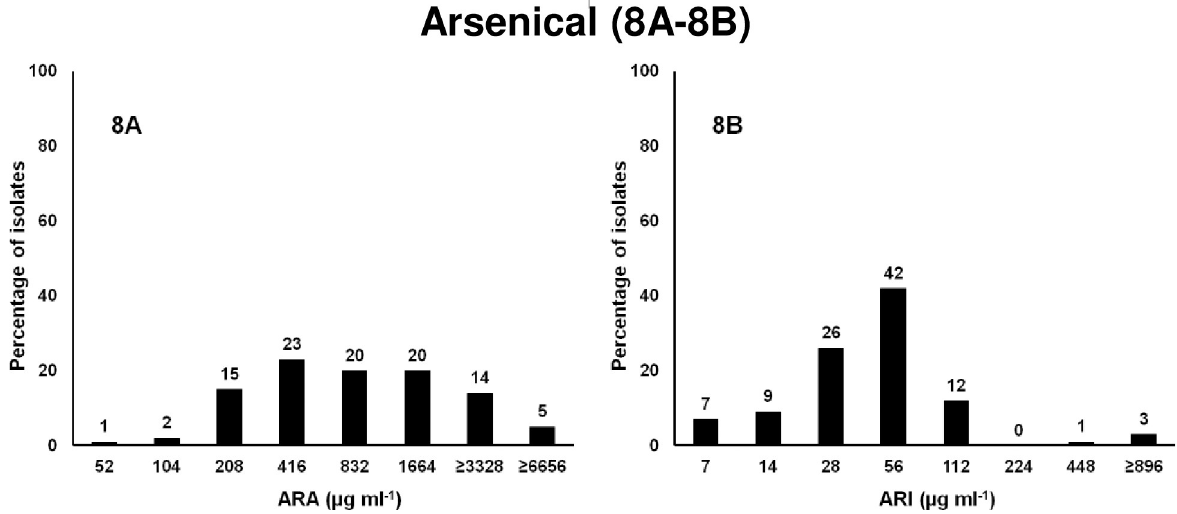
Fig 8. Frequencies of the MICs of 88 MDR Salmonella isolates to arsenical compounds. X-axis is the 2-fold increase of biocide concentration; y- axis is percentage of isolates susceptible at each concentration. 8A. ARA, arsenate; and 8B. ARI, aresenite.